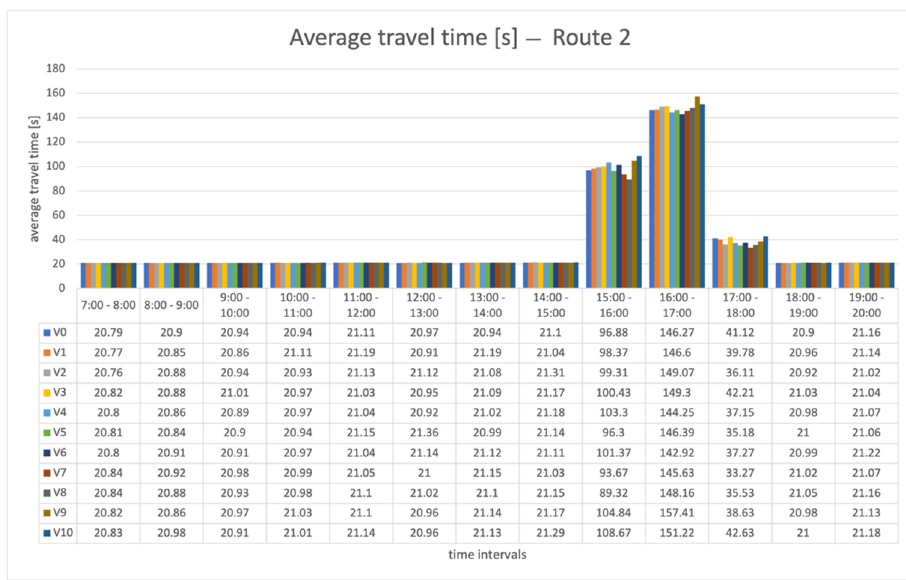
Figure 9. Average travel time; Section 2—all variants.